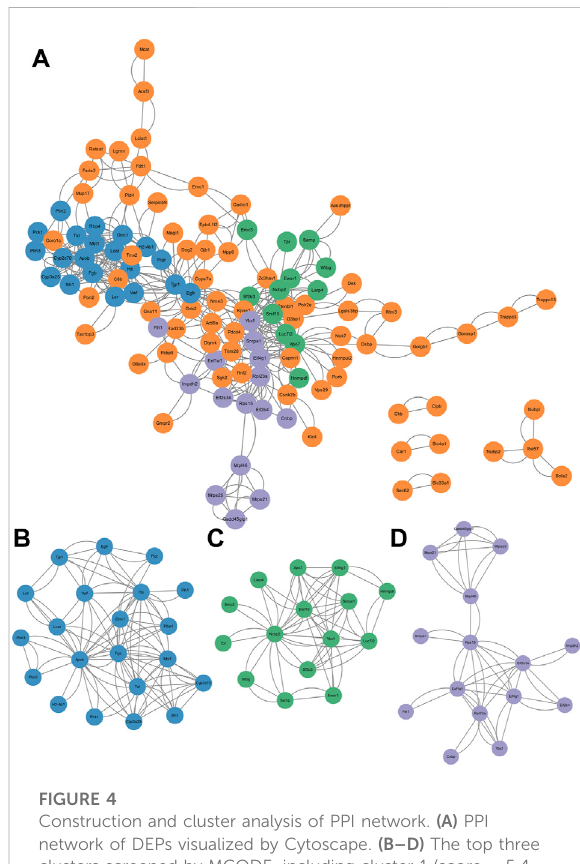
FIGURE 4 Construction and cluster analysis of PPI network. (A) PPI network of DEPs visualized by Cytoscape. (B – D) The top three clusters screened by MCODE, including cluster 1 (score = 5.4, nodes = 21, edges = 108), cluster 2 (score = 4.4, nodes = 15, edges = 62), and cluster 3 (score = 3.6 nodes = 15, edges = 50).